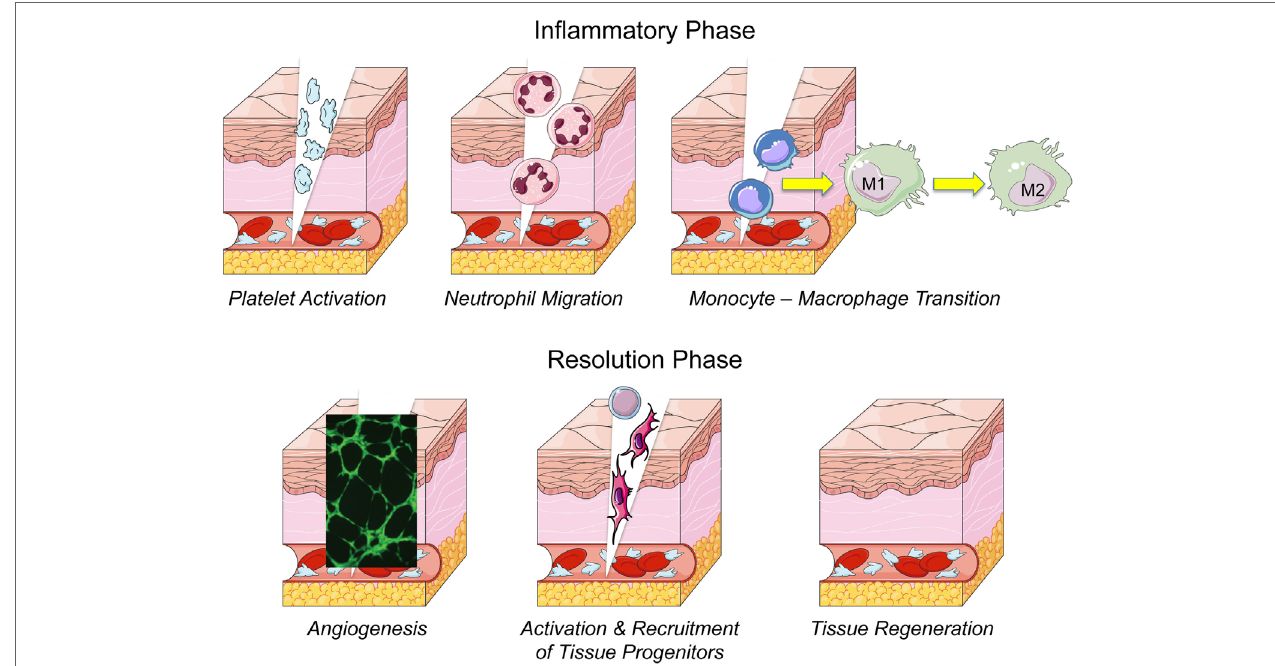
FiGURe 1 | Main events and phases of the wound healing process